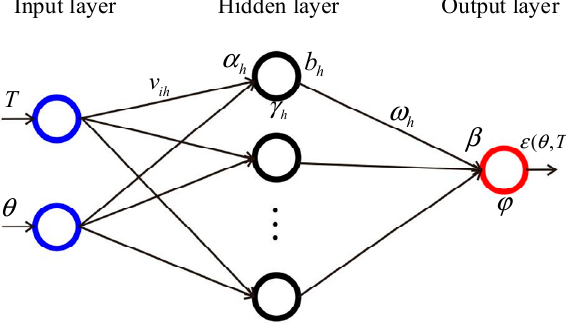
Figure 3. Structure of the BP neural network.